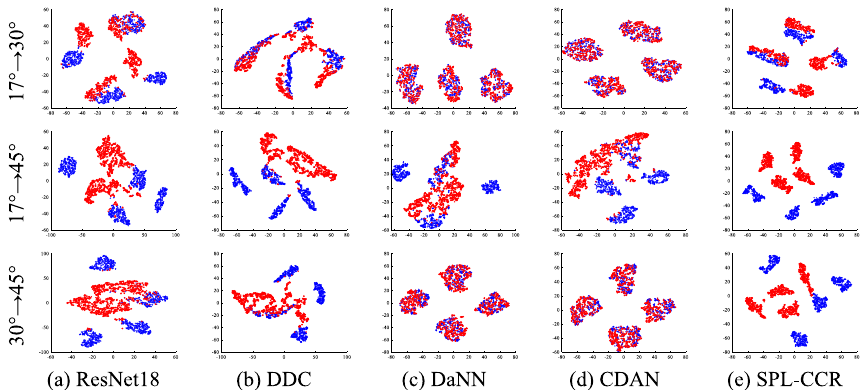
Fig. 6 Visualization of features in the domain adaptation layer of each network (blue and red dots represent the source domain samples and target domain samples, respectively). a ResNet18. b DDC. c DaNN. d CDAN. e SPL-CCR. Each row corresponds to a single task, i.e., 17 ◦ → 30 ◦ , 17 ◦ → 45 ◦ and 30 ◦ → 45